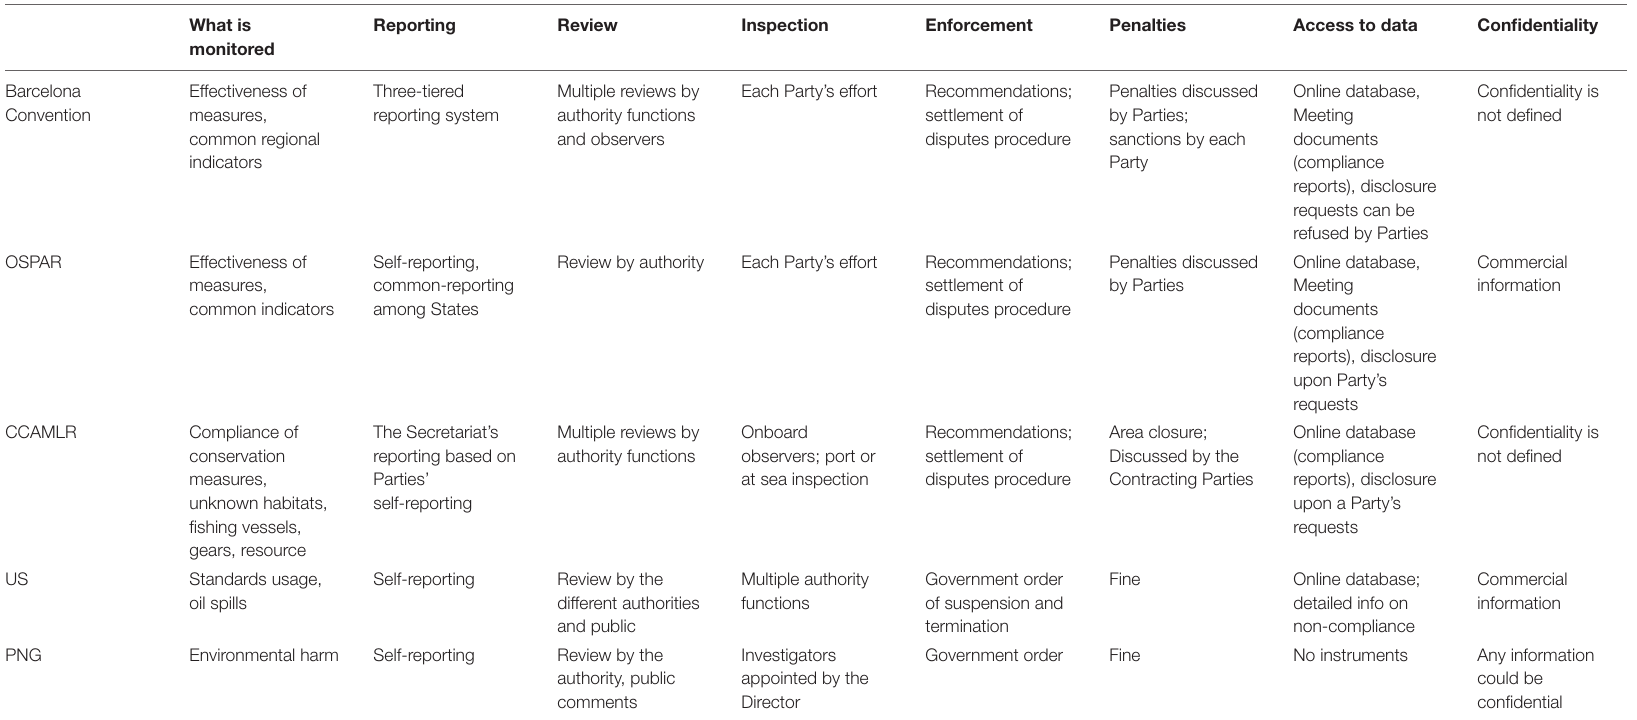
TABLE 4 | Summary of the characteristics of monitoring systems in the case